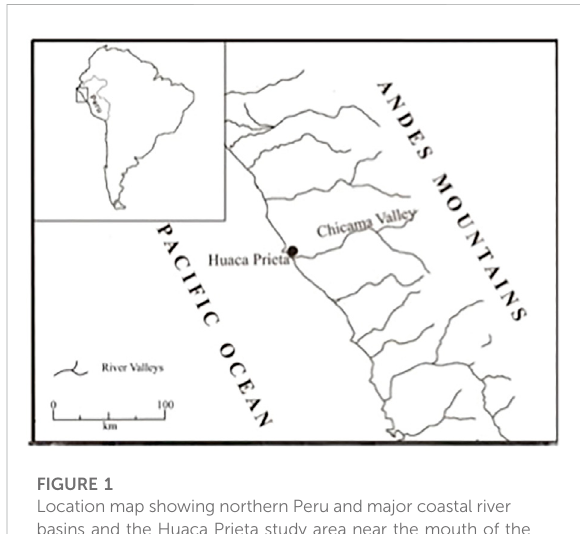
Location map showing northern Peru and major coastal river basins and the Huaca Prieta study area near the mouth of the Chicama